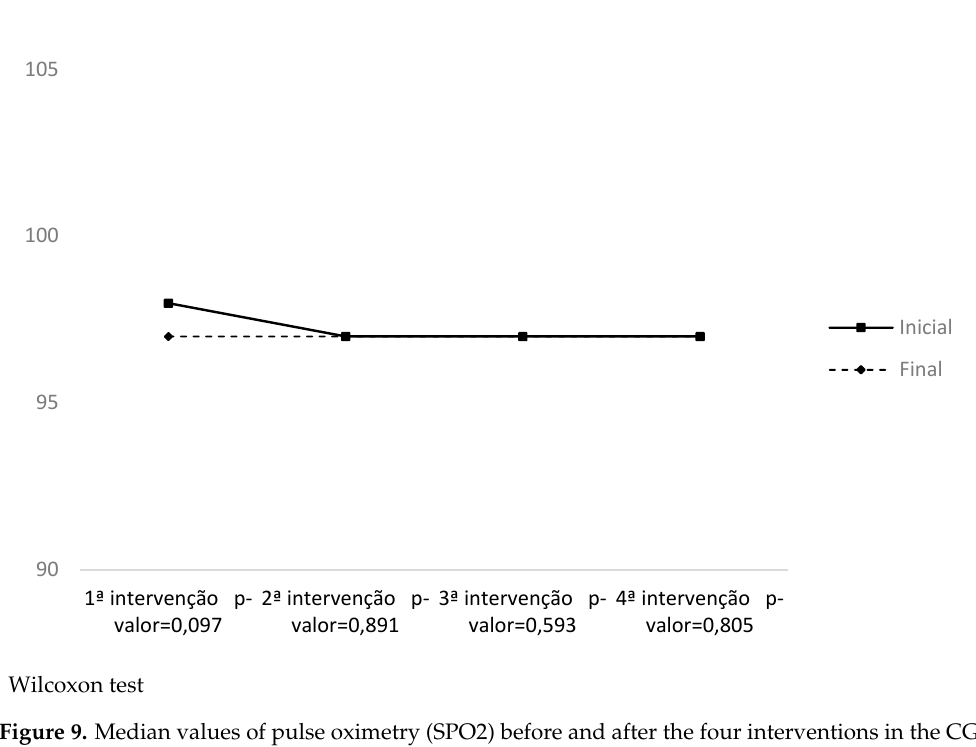
Figure 8. Median values of heart rate (HR) before and after the four interventions in the CG (educational activity).